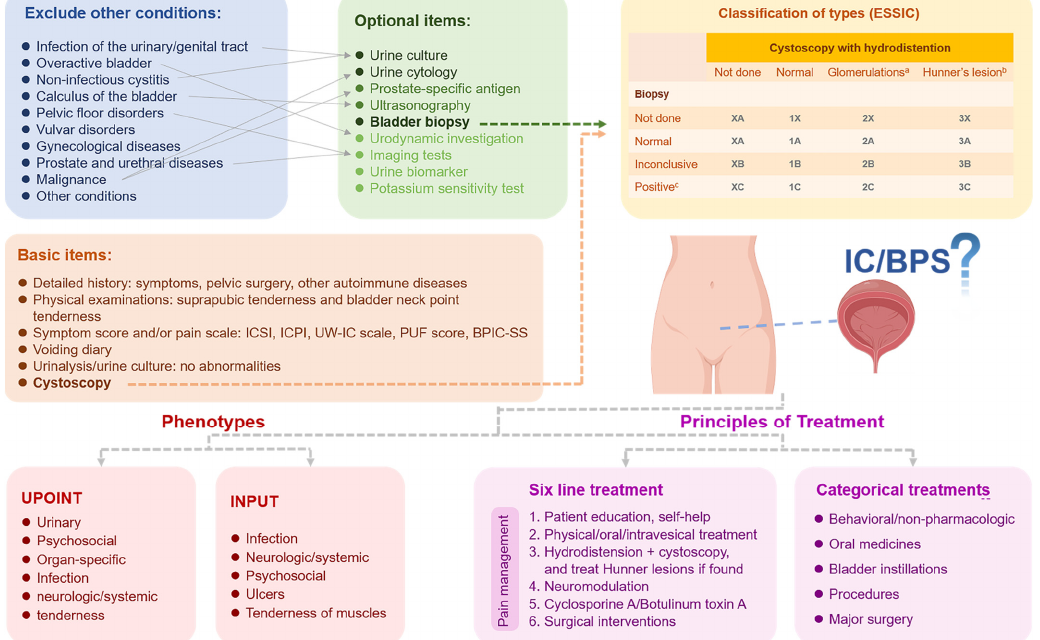
Figure 1. Diagnostic key points, phenotypes classifications, and principles of treatments for interstitial cystitis/bladder pain syndrome (IC/BPS). Conditions in blue square represent the diagnosis of exclusion. Examination in green square represent the optional items that followed by symptoms in the blue square. Items in orange square represent the basic diagnostic points. Yellow square represents the classification of types in IC/BPS diagnosed by cystoscopy and bladder biopsy. Red squares represent two phenotypes in IC/BPS and purple squares represents two different principles of treatment of IC/BPS. a Cystoscopy: glomerulations grade 2–3; b With or without glomerulations; c Histology showing inflammatory infiltrates and/or detrusor mastocytosis and/or granulation tissue and/or intrafascicular fibrosis. IC/BPS, interstitial cystitis/bladder pain syndrome; ESSIC, European Society for the study of IC/BPS; ICSI, Interstitial Cystitis Symptom Index; ICPI, Interstitial Cystitis Problem Index; UW-IC scale, Wisconsin Interstitial Cystitis scale; PUF score, Pain, Urgency, and Frequency score; BPIC-SS, Bladder Pain/IC Symptom Score. 4. Treatment of IC/BPS 4.1. Principles of Treatments The therapeutic goal is to relieve bladder pain, diminish urgency and frequency, and improve the quality of life (QoL) in patients. However, as the imprecise pathogenic factors and heterogeneity in individuals indicate, the modalities for IC/BPS vary. Individual targeted therapy, therefore, is a necessity. The UPOINT phenotypic classification system developed by Shoskes was recommended by CUA, EAU, and two clinical trials [9,63,64]. Both studies found that approximately 50% of IC/BPS patients treated with corresponding modalities could achieve significant symptomatic improvements. In addition, a novel phenotypic classification system termed INPUT may better meet the demand for personalization than the prior version, although it requires further validation [10] (Figure 1). AUA has advocated for the six-line treatment since 2011, which consequently boosts the hierarchical standard treatment for IC/BPS [7]. Moreover, in the 2022 version of AUA [1], the panel has transformed this linear system into a more categorical program: from